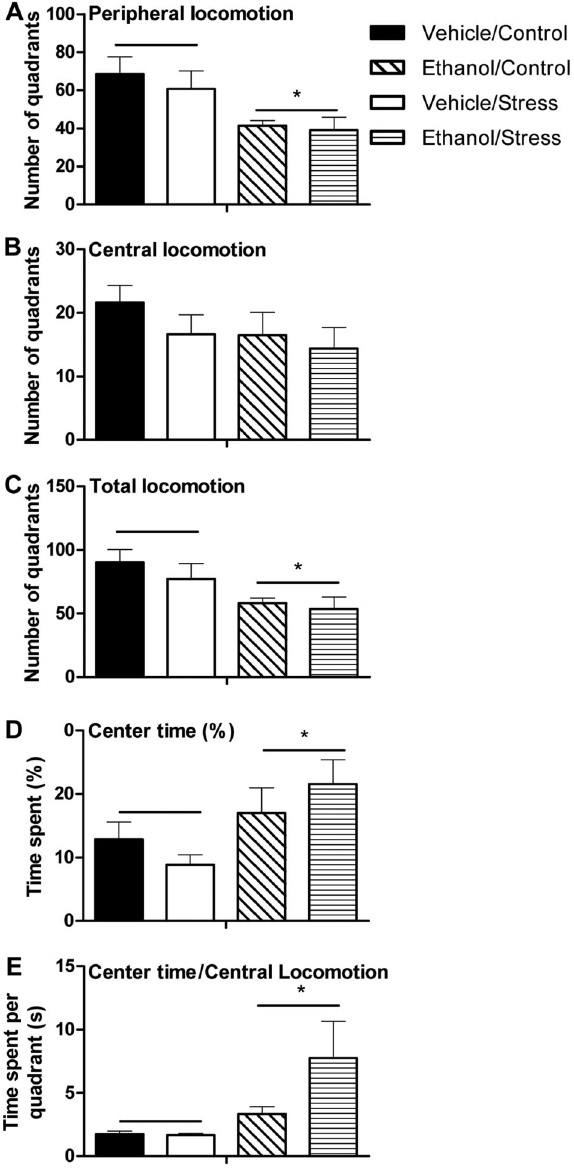
Figure 3. Locomotor activity of mice exposed to the open fi eld apparatus after chronic administration of ethanol and stress testing. Mice were tested for 5 min after 14 h of ethanol withdrawal. Data are reported as means ± SE. A , Number of quadrants travelled in the periphery of the apparatus; B , number of quadrants travelled in the center of the apparatus; C , number of quadrants travelled in the total area of the apparatus; D , percentage of time spent in the center of the apparatus; E , time spent in each central quadrant. *P o 0.05 compared with vehicle-treated groups for n=8 – 10 animals per group (two-way ANOVA